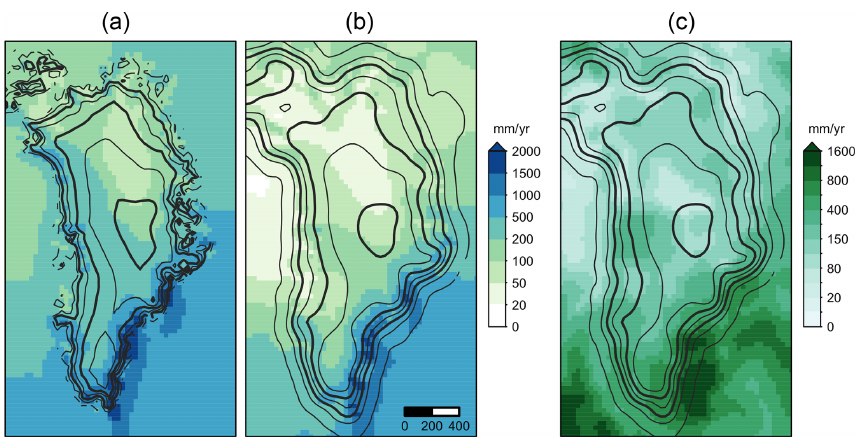
Figure 3. Climate snapshots. Mean annual present-day (a) and LGM (b) precipitation snapshots, along with the uncertainty in the LGM pre- cipitation (c) . Present-day climate is the 1981–2010 average from the regional climate model (MARv3.9). LGM precipitation and uncertainty are the mean and standard deviation of model results contributed to the PMIP3 database.